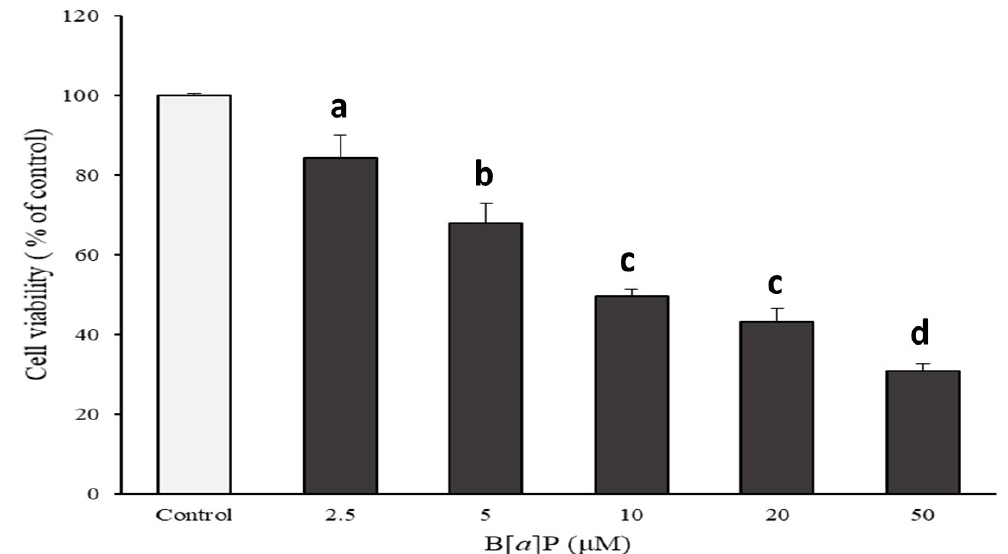
Figure 1. Effects of Benzo[a]pyrene (B[ α ]P) on cell viability (% of control). human liver hepatocellular carcinoma (HepG2) cells were treated with different concentrations of B[ α ]P for 24 hr. The values are mean ± SD in triplicate. Each bar with different letters is significantly different. a p < 0.01 as compared with control; b p < 0.001 as compared with control; c p < 0.001 as compared with control; d p < 0.001 as compared with control. Control indicates HepG2 treated by Dulbecco's Modified Eagle Medium (DMEM) without B[ α ]P.